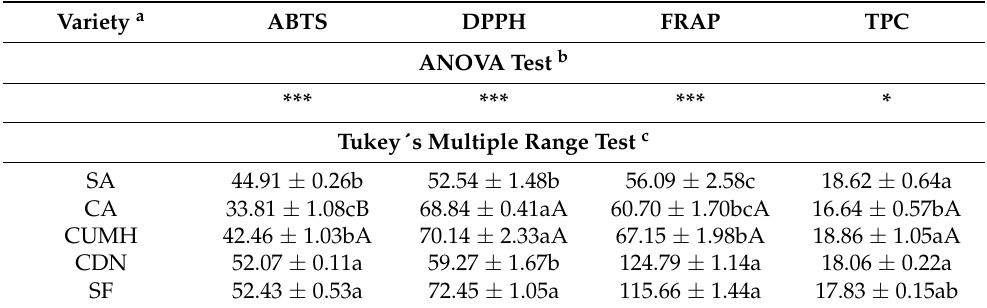
Table 4. Antioxidant activity (ABTS, DPPH, and FRAP; mM Trolox dw) and total polyphenol content (TPC; g GAE kg − 1 dw) of Ficus carica leaves. Variety a ABTS DPPH FRAP TPC ANOVA Test b *** *** *** * Tukey ´ s Multiple Range Test c SA 44.91 ± 0.26b 52.54 ± 1.48b 18.62 ± 0.64a CA CUMH 42.46 ± 1.03bA 70.14 ± 2.33aA CDN 52.07 ± 0.11a SF 52.43 ± 0.53a 72.45 ± 1.05a 115.66 ± 1.44a 17.83 ±